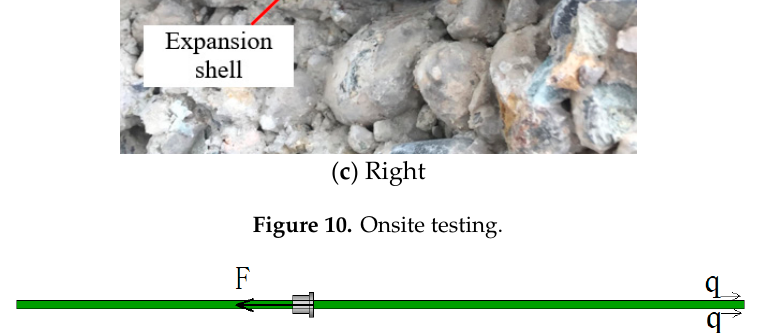
Figure 11. Schematic of rock bolt force.